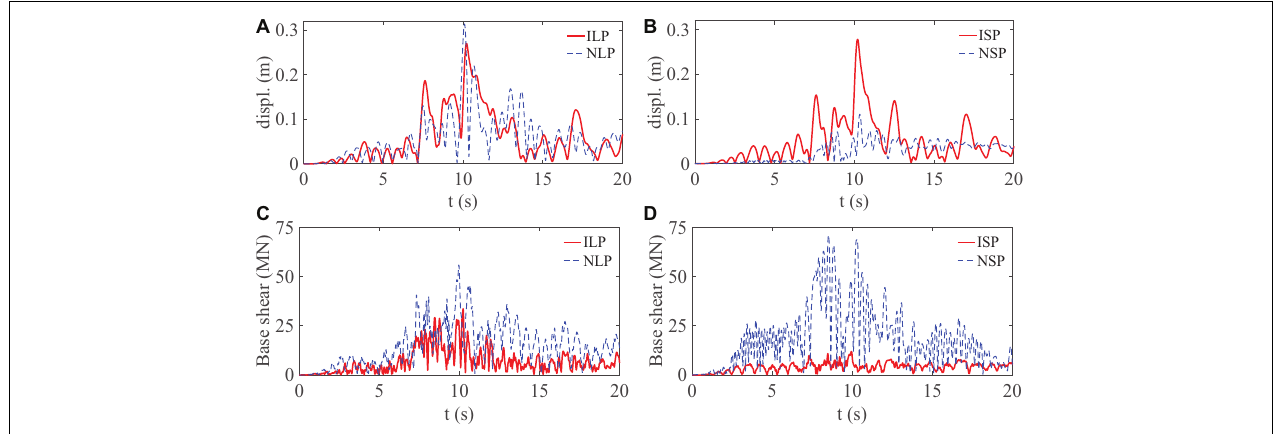
FIGURE 6 | Time history of the resultant responses of different bridge models under an FF record pair from the 1995 Kobe earthquake: (A,B) the deck resultant displacement at the location of pier P 7 ; (C,D) the bridge resultant base-shear.